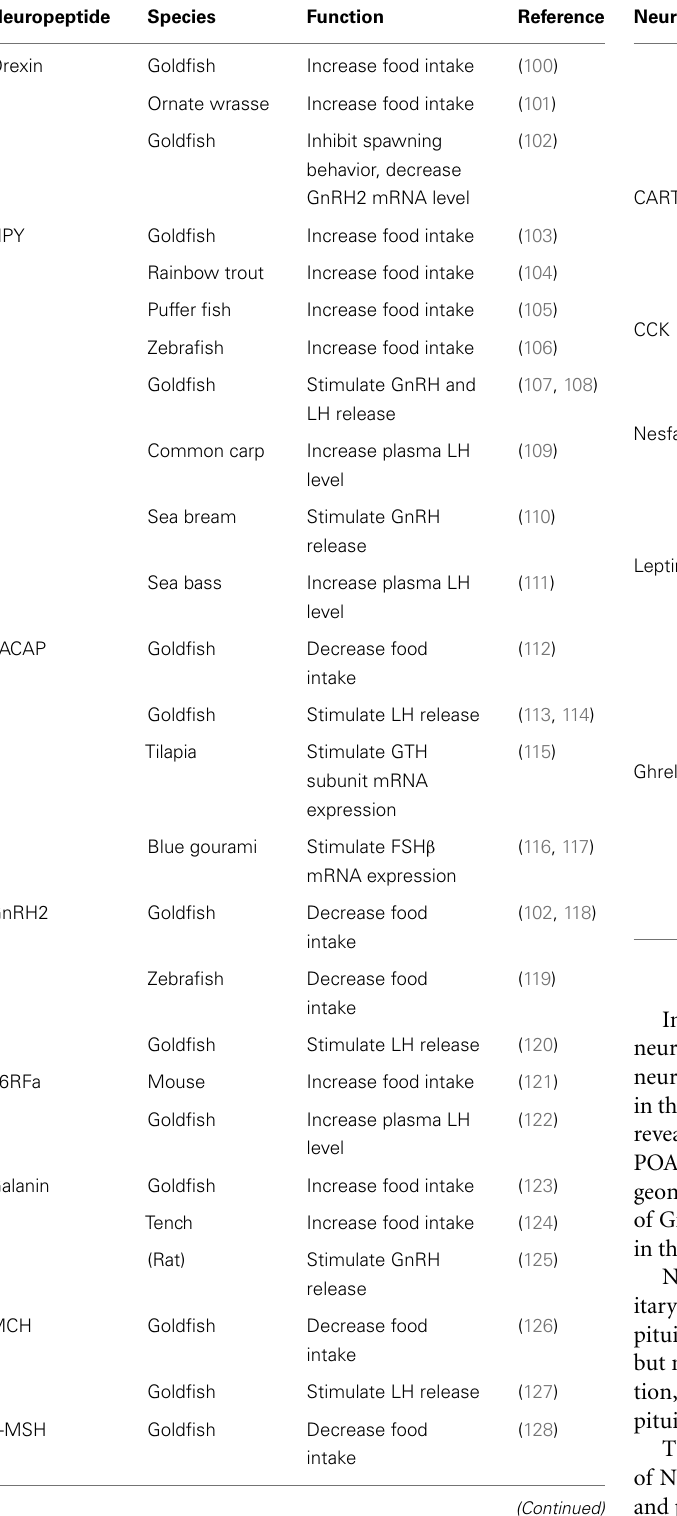
Table 1 | Neuropeptides and their functions in representative fish species